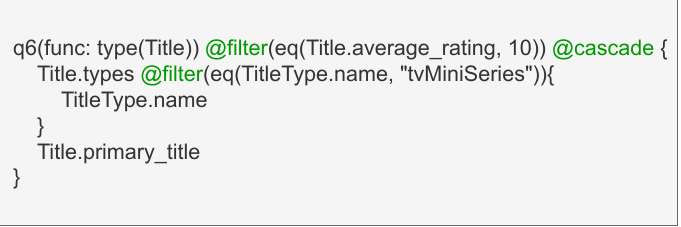
Figure 14. Q6 example for